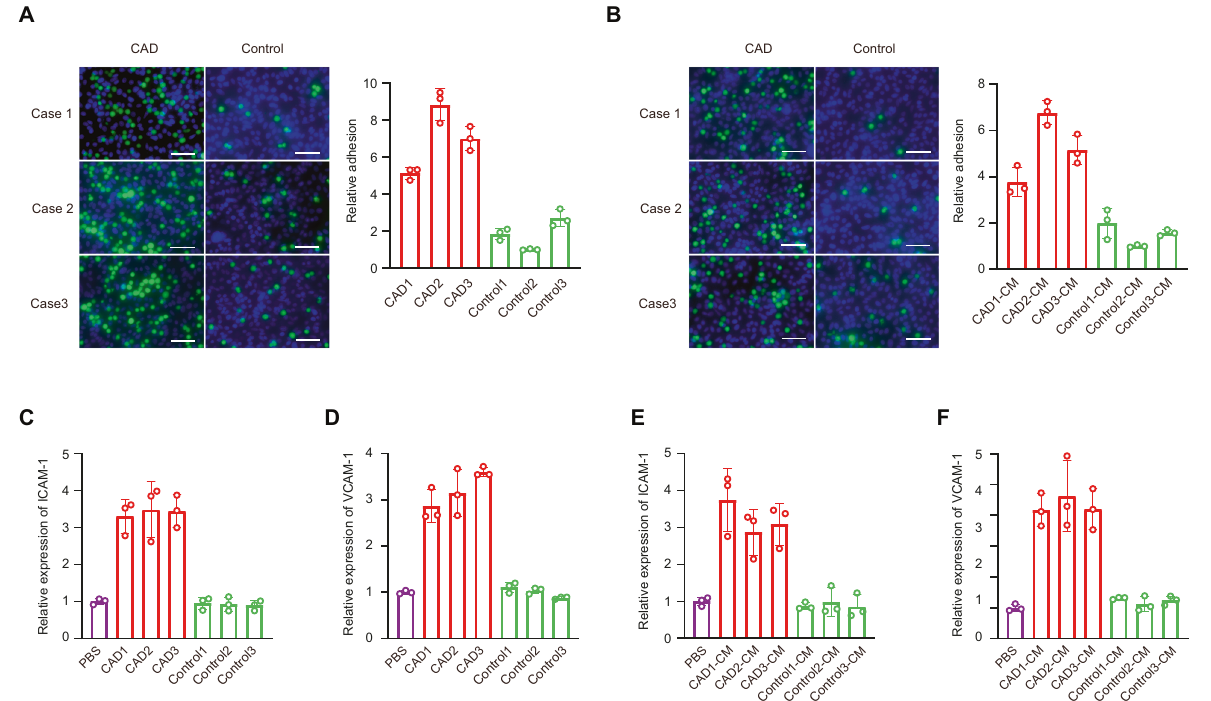
Fig. 1 Heterogeneous adhesion ability of the CAD-derived monocytes was increased compared with the adhesion ability of the control monocytes. Heterogeneous adhesion ability of monocytes to HCAECs was analyzed using monocytes ( A ) or monocytes culture medium (CM) ( B ). ICAM-1 ( C ) and VCAM-1 ( D ) expression in HCAECs cocultured with monocytes were analyzed using qRT-PCR. ICAM-1 ( E ) and VCAM-1 ( F ) expression in HCAECs cocultured with monocytes culture medium were analyzed using qRT-PCR. Scale bar = 50 µm. Data are presented as means ± SD; a signi fi cant difference was identi fi ed with Student ’ s t test. * P < 0.05; ** P < 0.01. ns (not signi fi